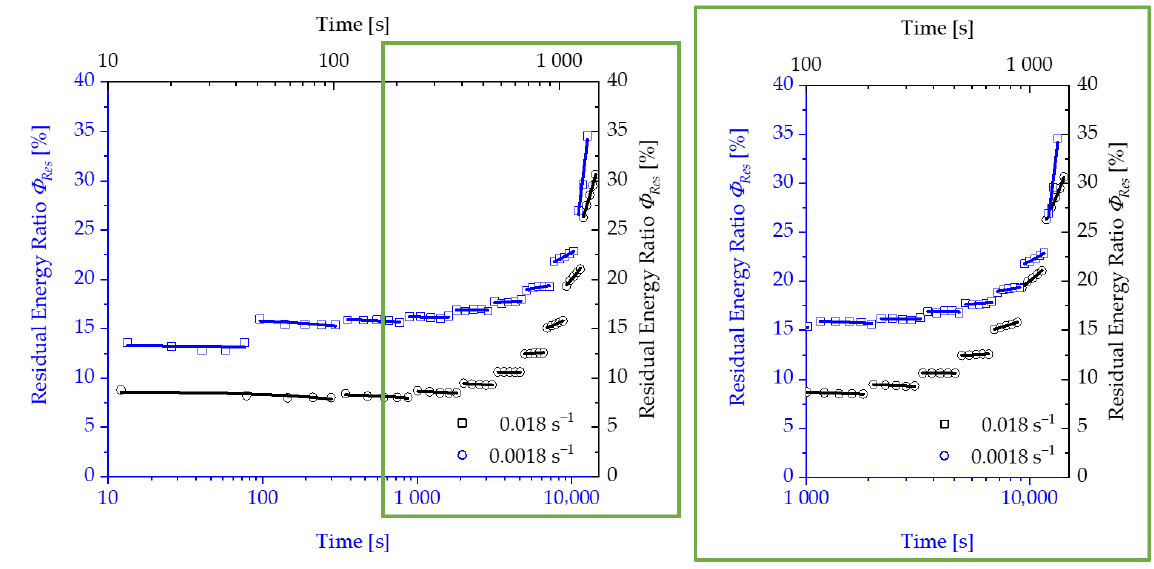
Figure 9. Development of the residual energy ratio